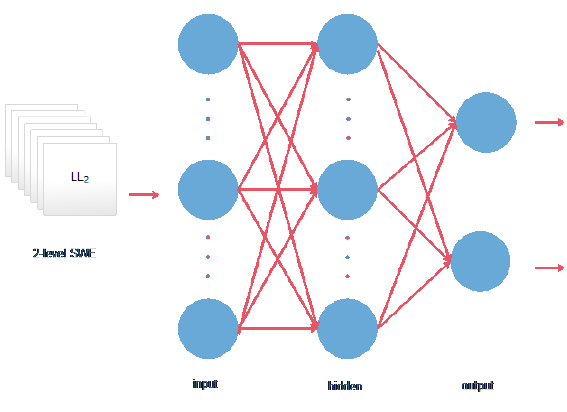
Figure 3. Diagram of the